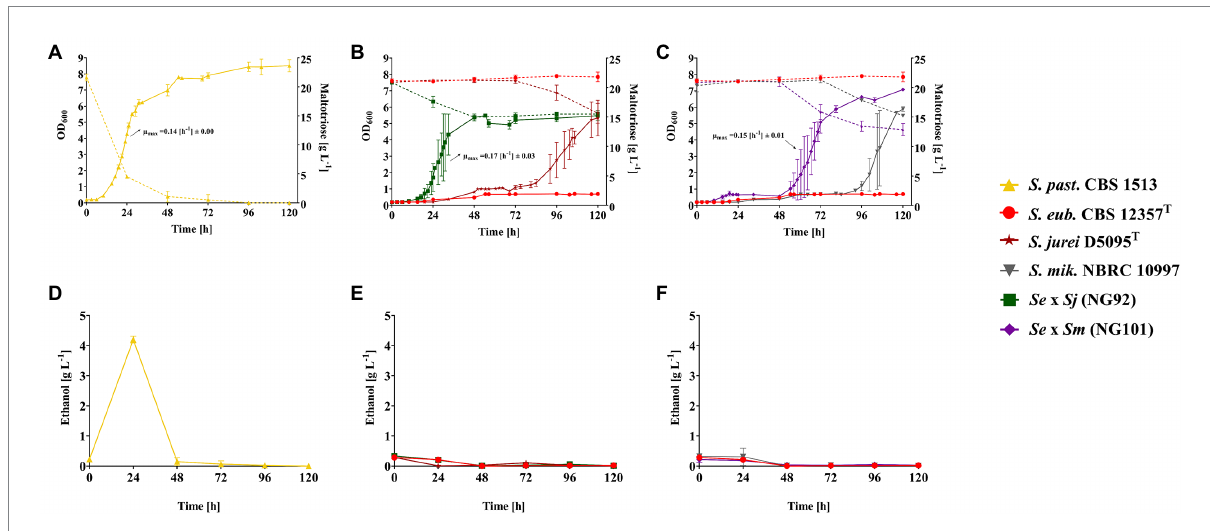
FIGURE 2 Growth in liquid synthetic medium with 2% (w/v) maltotriose (Mtt) of strains S. pastorianus CBS 1513 (Mtt + ; ▲ ), S. eubayanus CBS 12357 T (Mtt − ; ● ), S. jurei D5095 T (Mtt + ; ★ ), S. mikatae NBRC 10997 (Mtt + ; ▼ ) and the constructed de novo hybrids – NG92 ( S. eubayanus CBS 12357 T × S. jurei D5095 T / Se × Sj ; ■ ) and NG101 ( S. eubayanus CBS 12357 T × S. mikatae NBRC 10997/ Se × Sm ; ♦ ). Values are presented as mean and standard deviation of triplicate biological replicates. (A–C) Growth curves depicting OD 600 values and maltotriose consumption [g L − 1 ] illustrated with continuous and dotted lines, respectively. Maximum specific growth rates ( μ max [h − 1 ]) were calculated for all hybrids but not for the corresponding parental strains due to flocculation. (D–F) Ethanol production [g L − 1 ] measured every 24 h. Raw data are provided in Supplementary Table